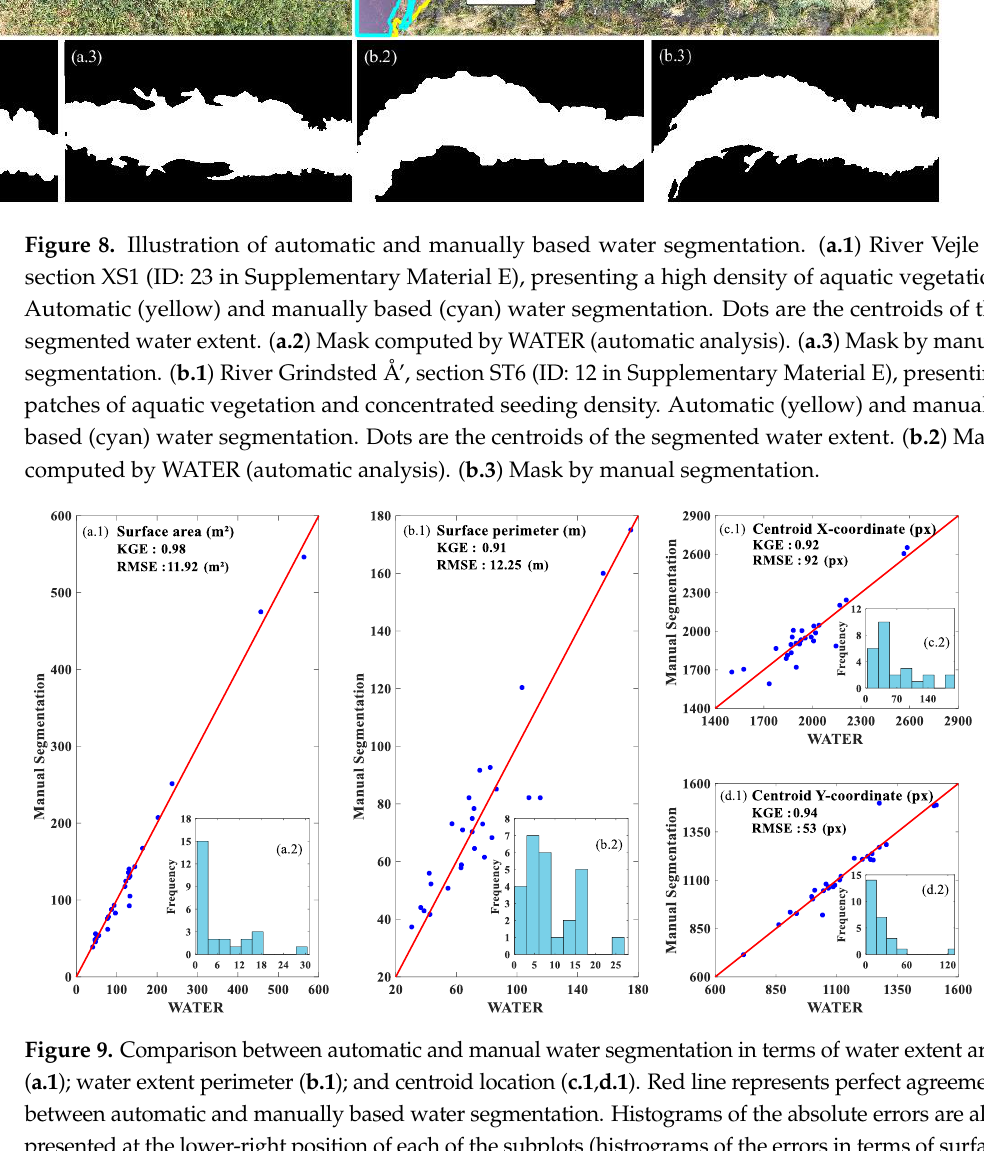
Figure 9. Comparison between automatic and manual water segmentation in terms of water extent area ( a.1 ); water extent perimeter ( b.1 ); and centroid location ( c.1 , d.1 ). Red line represents perfect agreement between automatic and manually based water segmentation. Histograms of the absolute errors are also presented at the lower-right position of each of the subplots (histrograms of the errors in terms of surface area, surface perimeter, centroid x- and y-coordinates are in ( a.2 , b.2 , c.2 , d.2 )